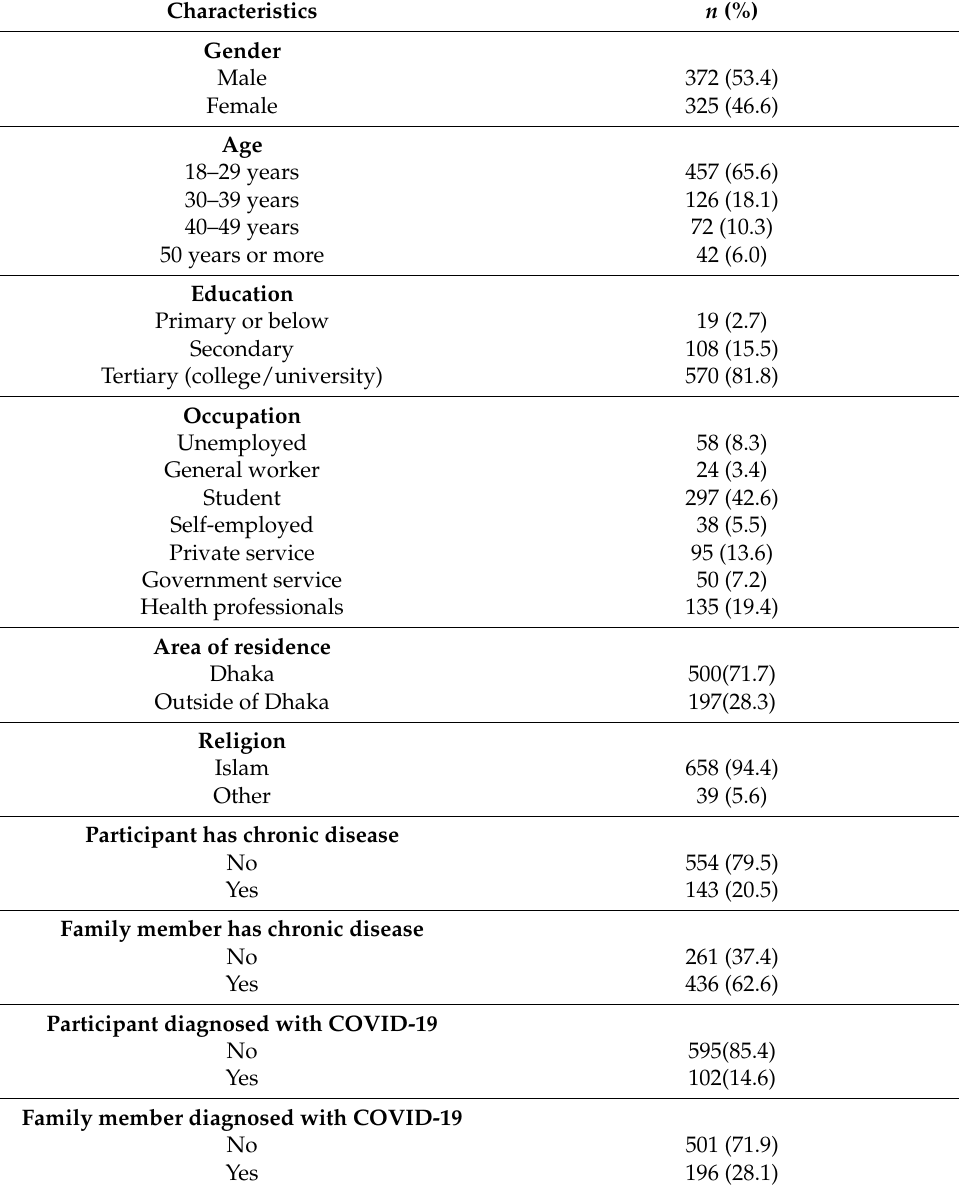
Table 1. Characteristics of the participants, COVID-19 vaccination intent and WTP, cross-sectional survey, January 2021,